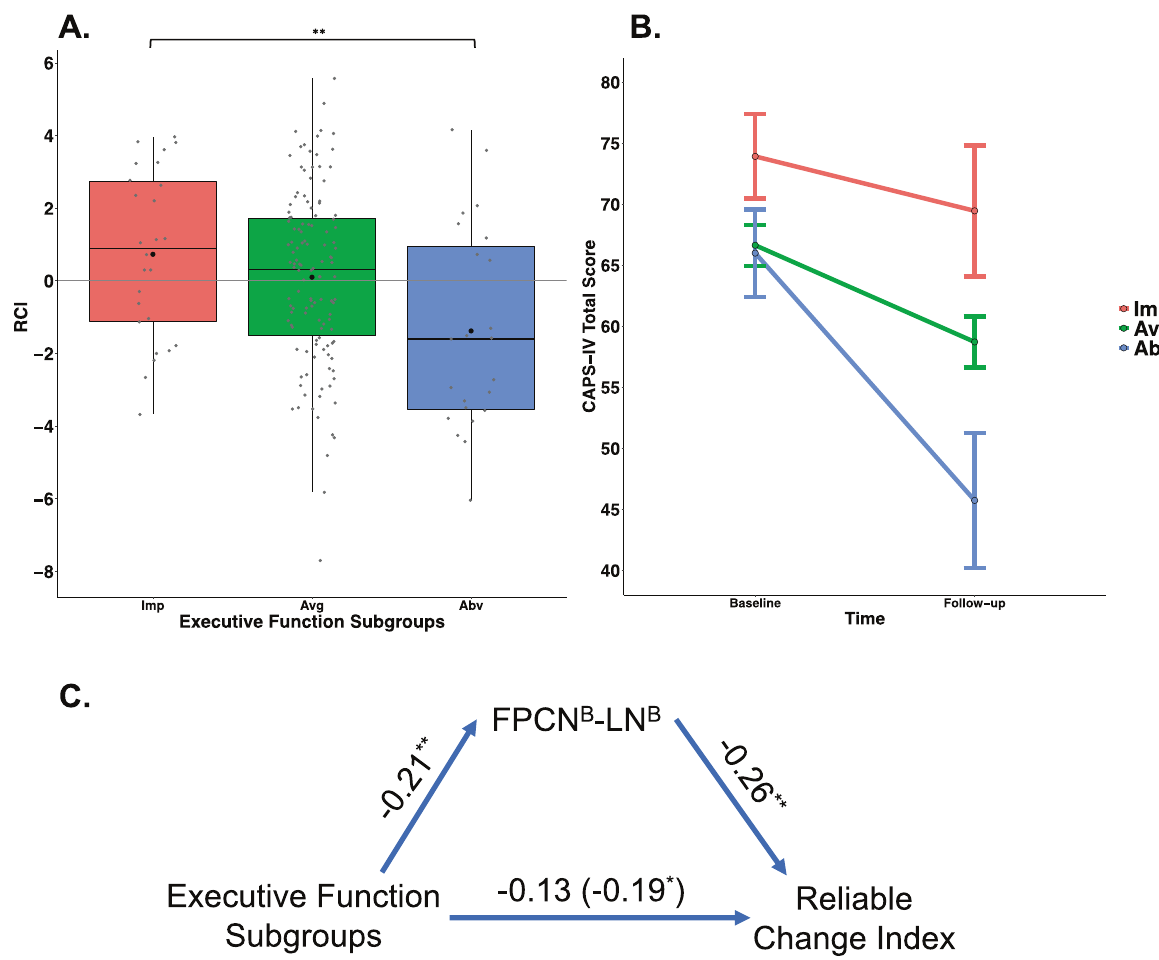
Fig. 3 PTSD chronicity. A Change in PTSD over time for each EF subgroup. Higher RCI scores indicate increasing scores on the CAPS-IV (worsening symptoms) whereas lower RCI indicates decreasing scores on the CAPS-IV (improving symptoms), ** indicate a signi fi cant main effect of EF subgroups predicting reliable change index, p = 0.003. Within each box, the dot denotes the mean, and the horizontal line denotes the median. The box indicates the interquartile range (the 25th to the 75th percentile) and vertical line from each box indicates the largest and the smallest value that fall within 1.5 times the interquartile range. B Change in PTSD (CAPS) over time for each EF subgroup. PTSD was most chronic in those with impaired EF and improved the most in those with above-average EF. Bars indicate the standard error of the mean. C Visualization of the signi fi cant mediation model whereby FPCN B -LN B functional connectivity mediates the relationship between EF subgroups and change in PTSD over time (RCI). * p < 0.05 , ** p < 0.01 . EF executive functioning, RCI reliable change index, Imp impaired EF subgroup, Avg average EF subgroup, Abv above-average EF subgroup, FPCN frontal parietal control network, LN limbic